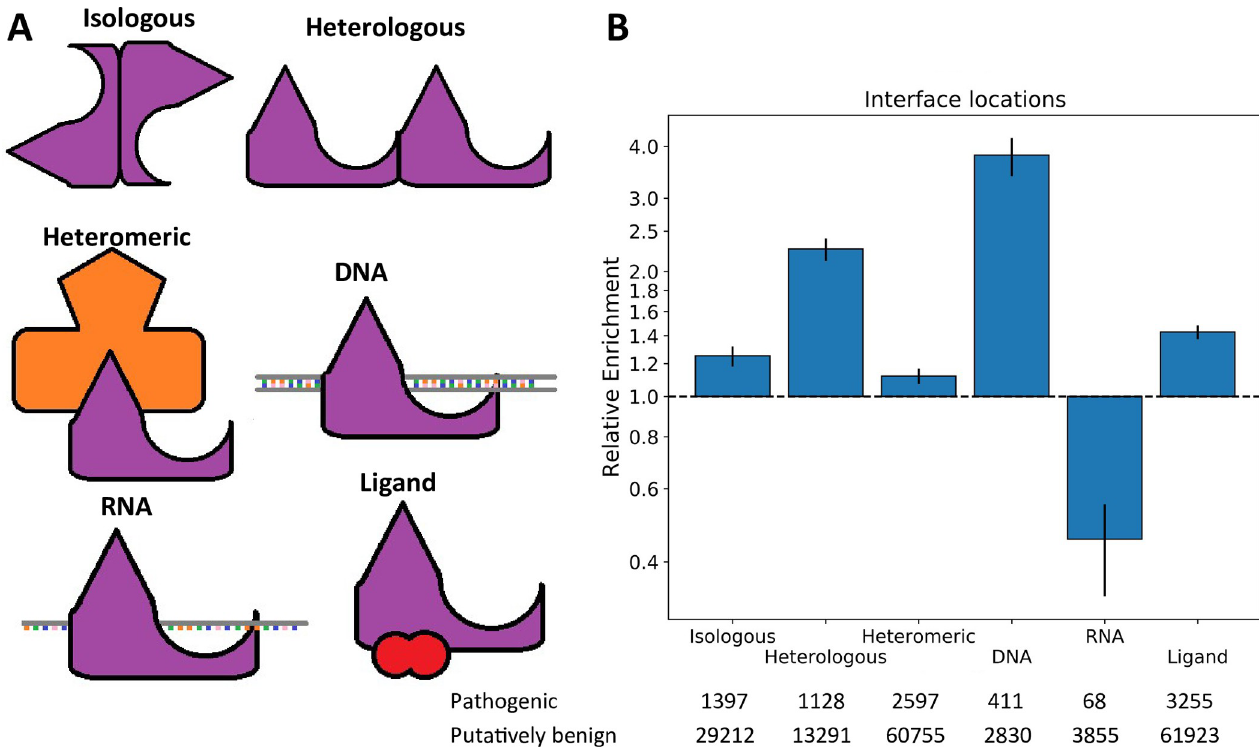
Fig 2. Comparison of the enrichment of pathogenic mutations at different protein interfaces. A) Demonstration of each protein interface type. B) Relative enrichment of pathogenic mutations within each interface type. Error bars represent 95% confidence intervals. Numbers of pathogenic and putatively benign mutations within each location dataset are shown. Detailed relative enrichment data is available in S1 Table.